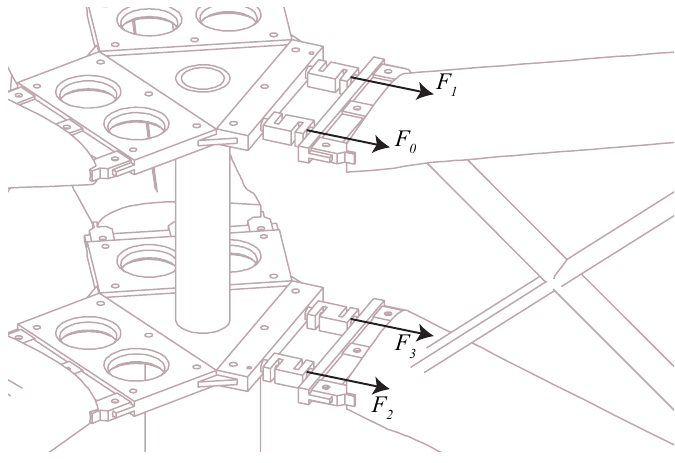
Figure 3. The assembly of the load cells. The notation of the measured